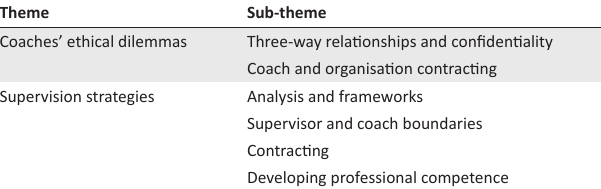
TABLE 2: Main and subthemes that emerged from supervisor interviews.